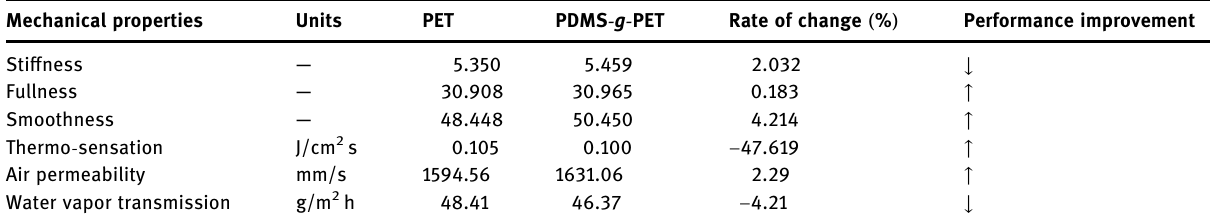
Table 1: The wearability of PET and PDMS - g - PET